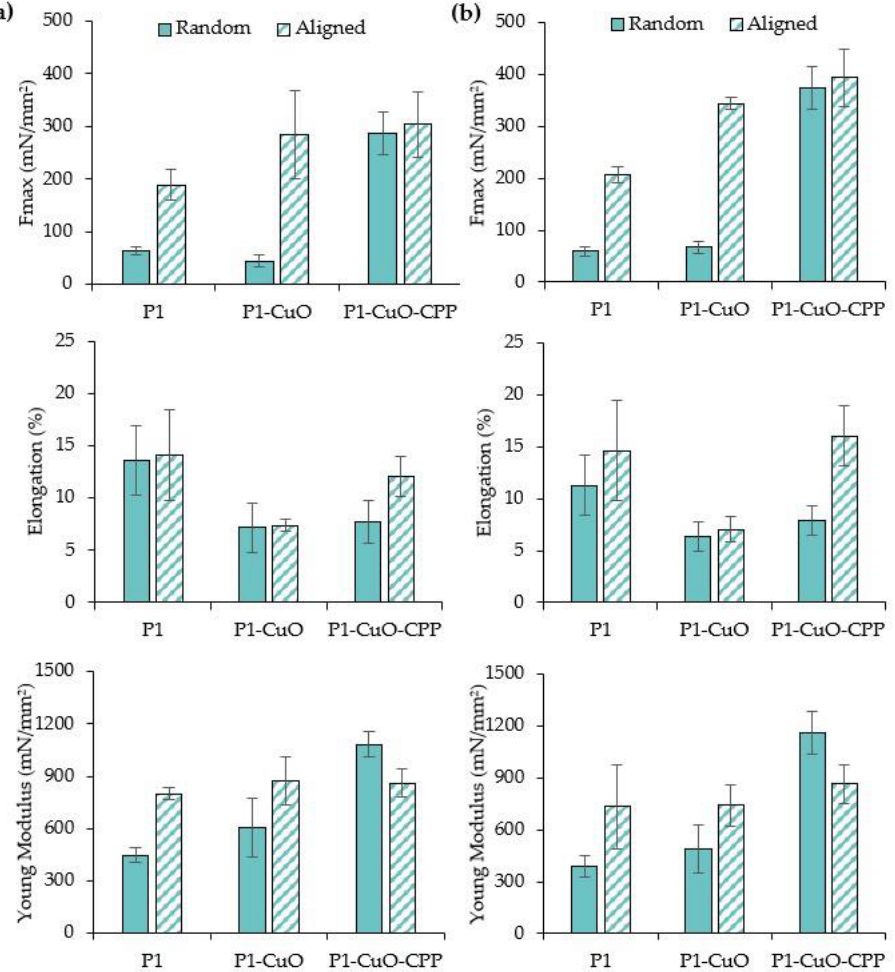
Figure 6. Maximum tensile force values (Fmax), elongation (%), and Young’s modulus (mN/mm 2 ) evaluated for P1, P1-CuO, and P1-CuO-CPP random (full color) and aligned (shaded color) scaffolds in both ( a ) dry and ( b ) hydrated states (mean values ± SD, n = 5). One-way ANOVA, Scheffé test ( p ≤ 0.05) is reported in the Supplementary Information (SI: Section S1.3.2).